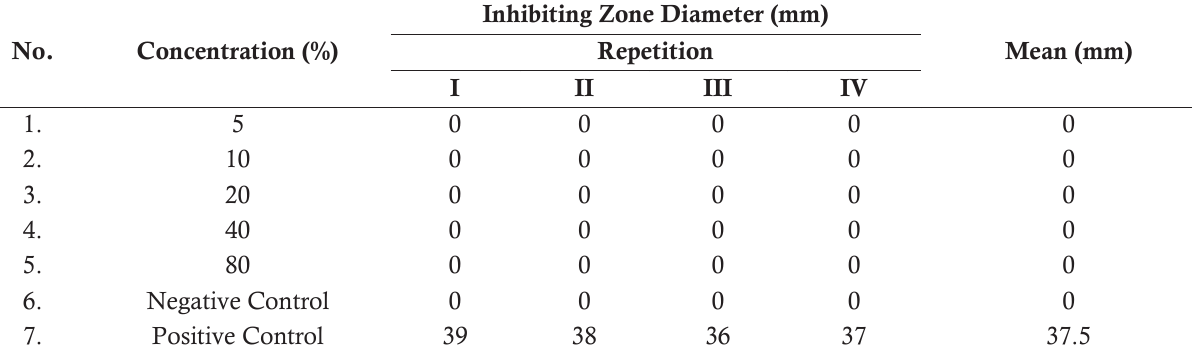
Table 2. Results of antifungal activity test on the ethanol extract of kesum leaves ( Polygonum minus Huds.)